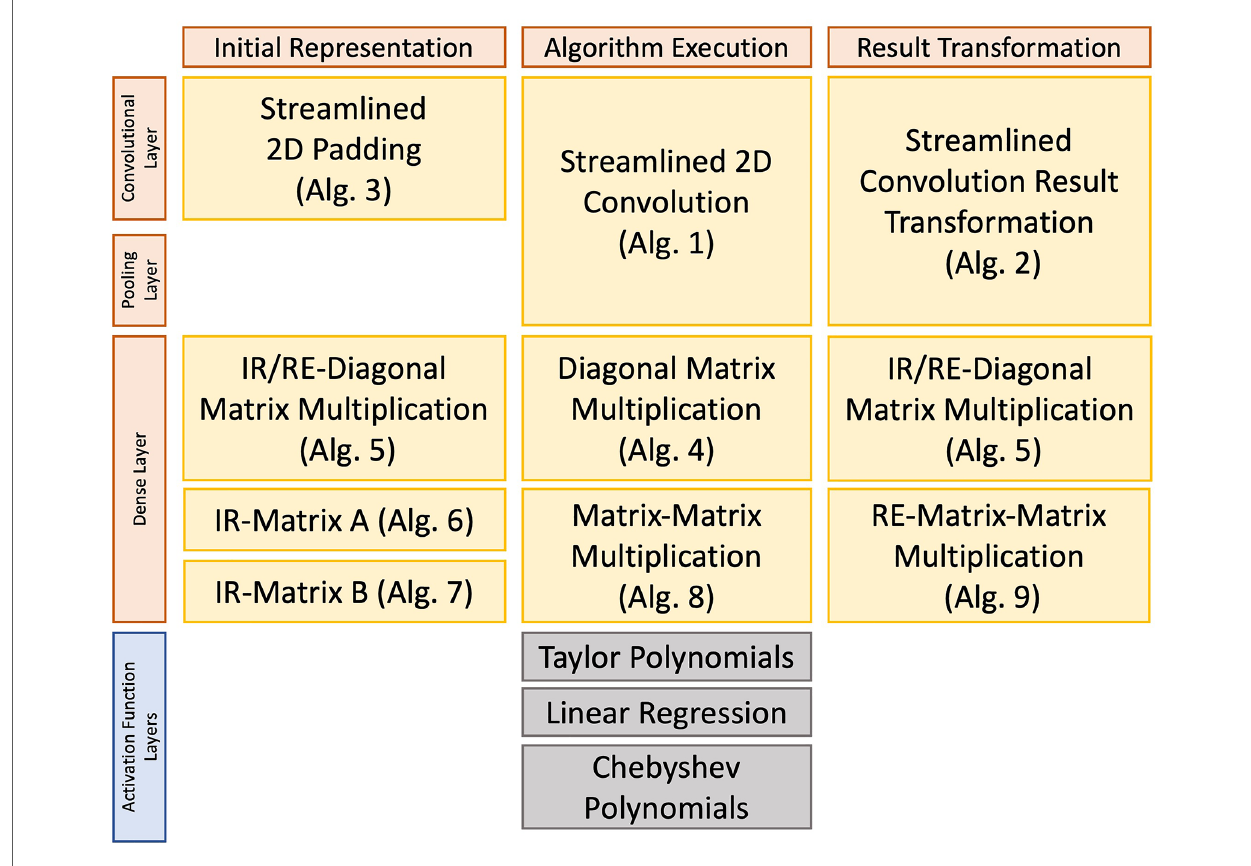
FIGURE 3 Overview of the different algorithms needed to perform a Convolutional Neural Network with Homomorphic Encryption.